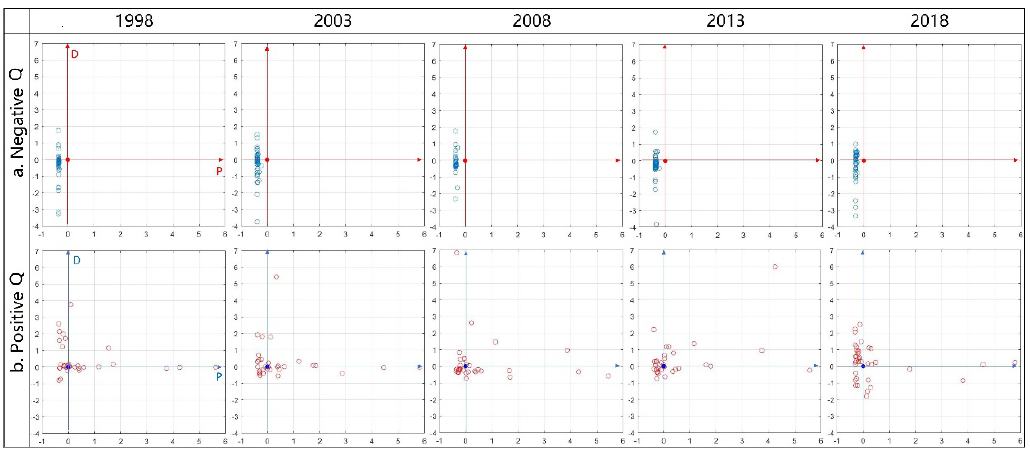
Figure 14. Multidimensional assessment results projected on Q plane at the county level.